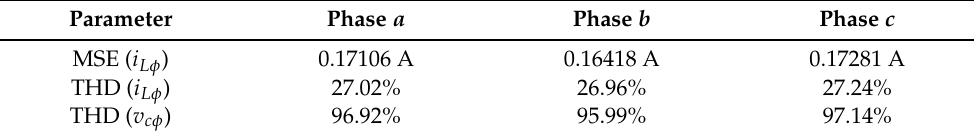
Table 12. Experimental results for FCS-MPC in the presence of parametric